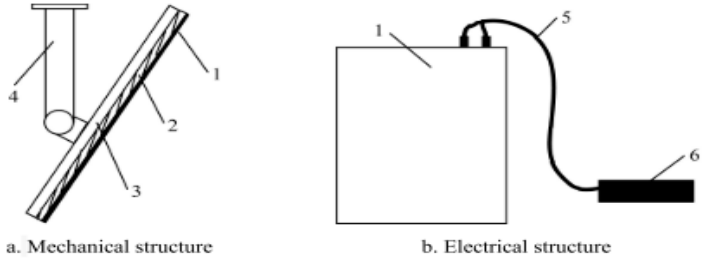
Figure 13. Structure of noble grain flow sensor. 1—PVDF piezoelectric film, 2—damping material, 3—impact plate, 4—fixed mount, 5—shielded wire, 6—charge amplifier [49].